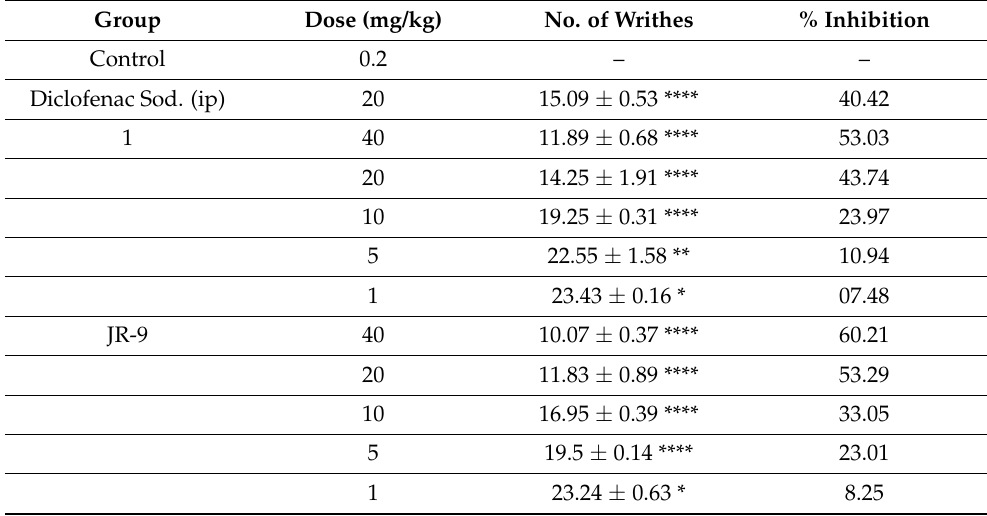
Table 2. The effects on writhing by 1 and JR-9 administered 30 min before intraperitoneal 0.6% acetic acid in mice. Each value represents mean ± SD or percentage inhibition of pain as compared to control animals, n = 5 (**** p < 0.0001, ** p < 0.001 * p < 0.05 indicated significant difference with the control group assessed by one-way ANOVA followed by Dunnett’s test). Group Dose (mg/kg) No. of Writhes % Inhibition Control 0.2 Diclofenac Sod. (ip)